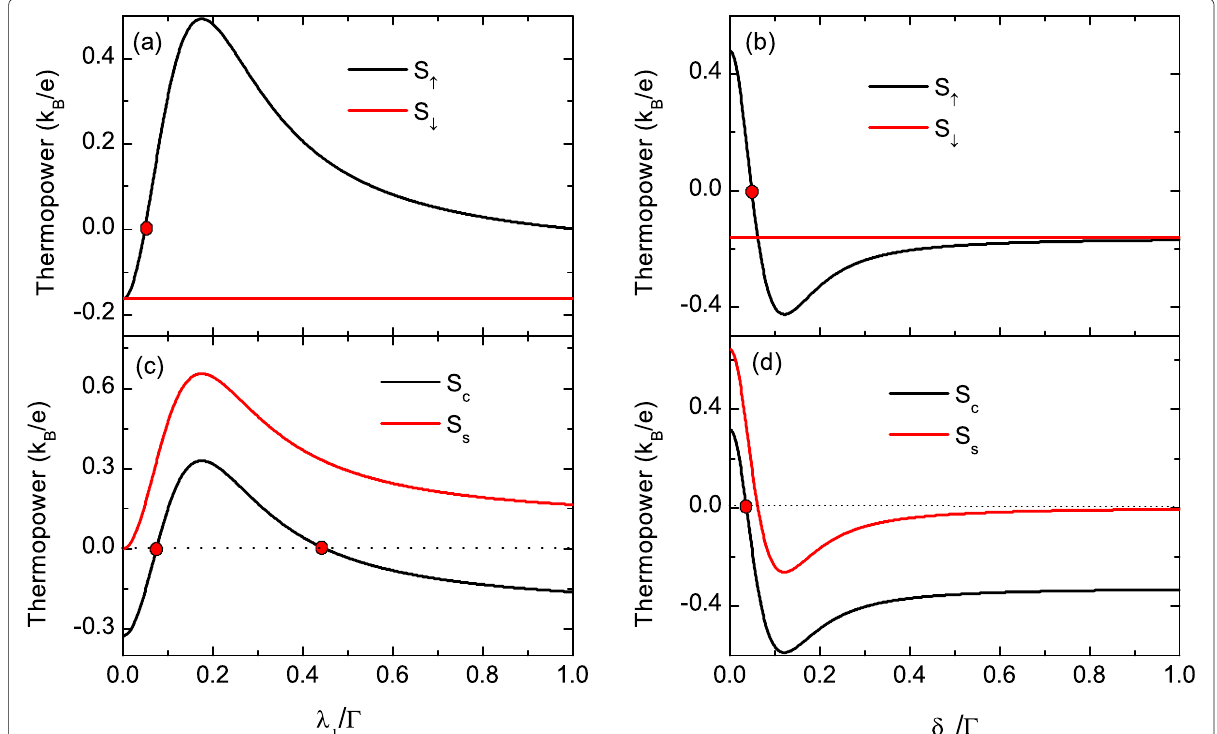
Fig. 4 Thermopowers varying with dot-Majorana coupling strength and direct overlap. The thermopowers as functions of λ 1 in a , b with (cid:10) M = 0, and (cid:10) M in c , d with λ 1 = 0.2 (cid:6) , respectively. Other parameters are the same as those of Fig.